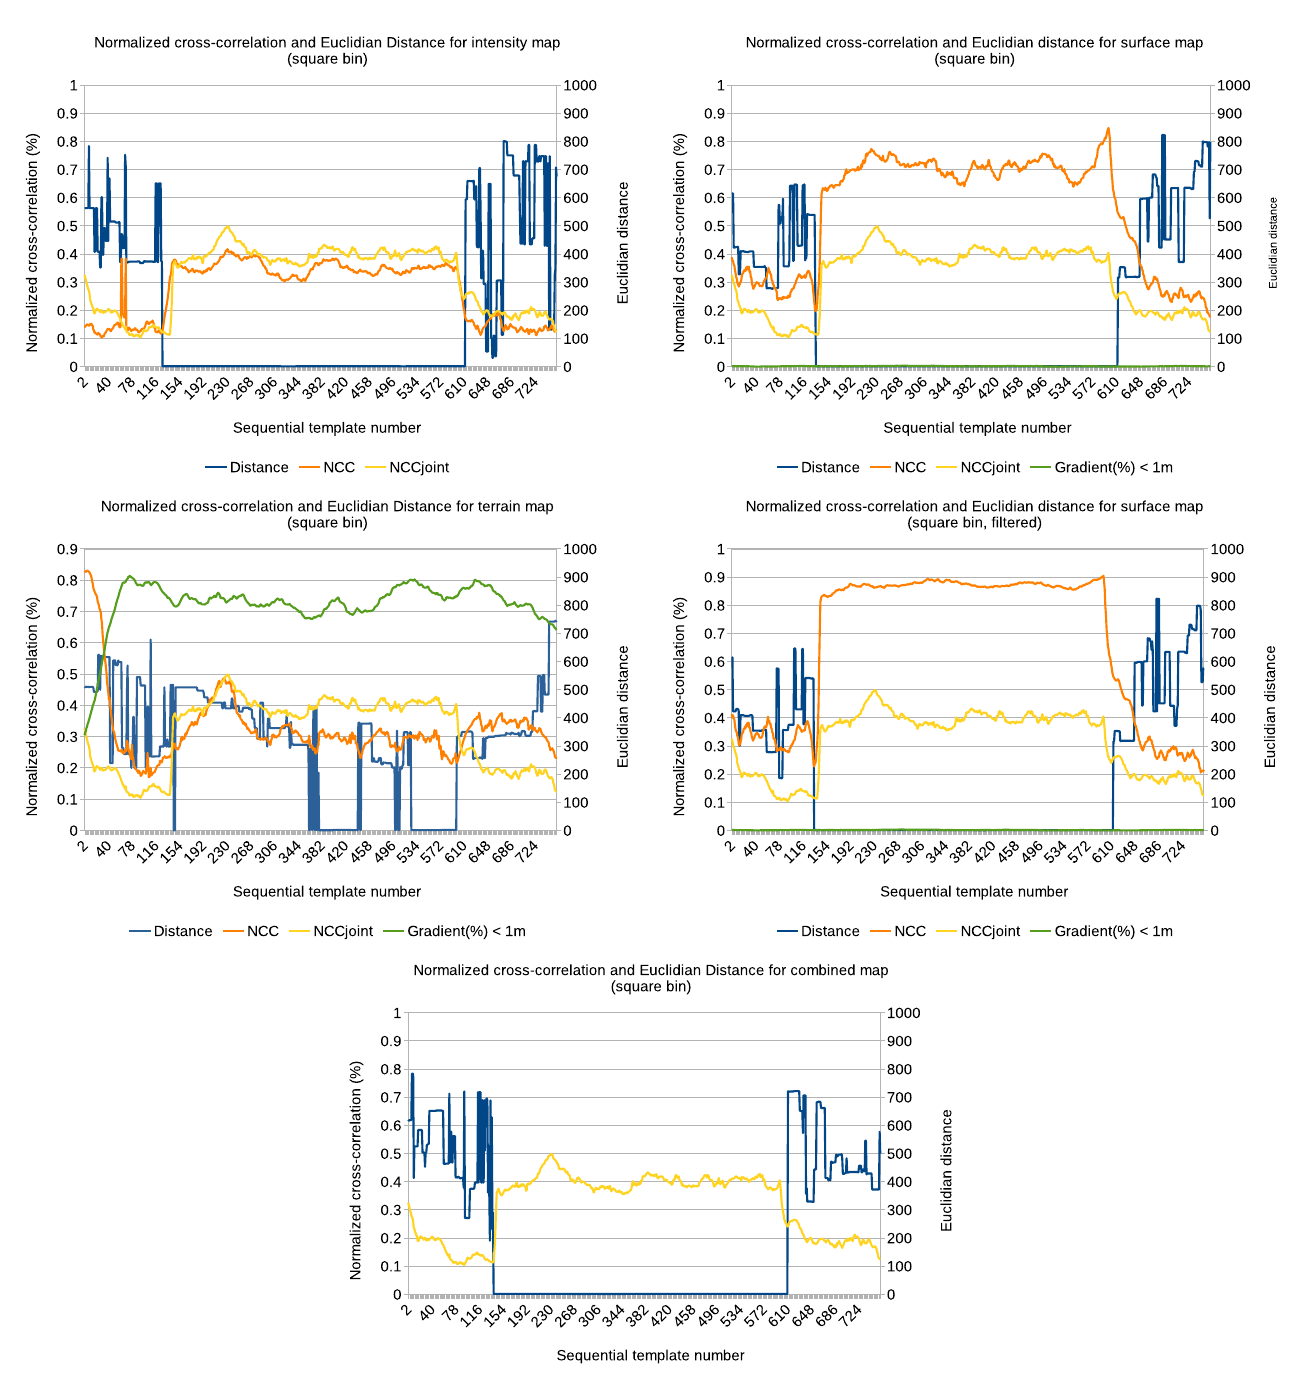
Figure 13. Matching results of intensity, surface, terrain, filtered surface and combined approaches. Square binning was utilized. NCC joint was replicated on the other graphs for facilitated